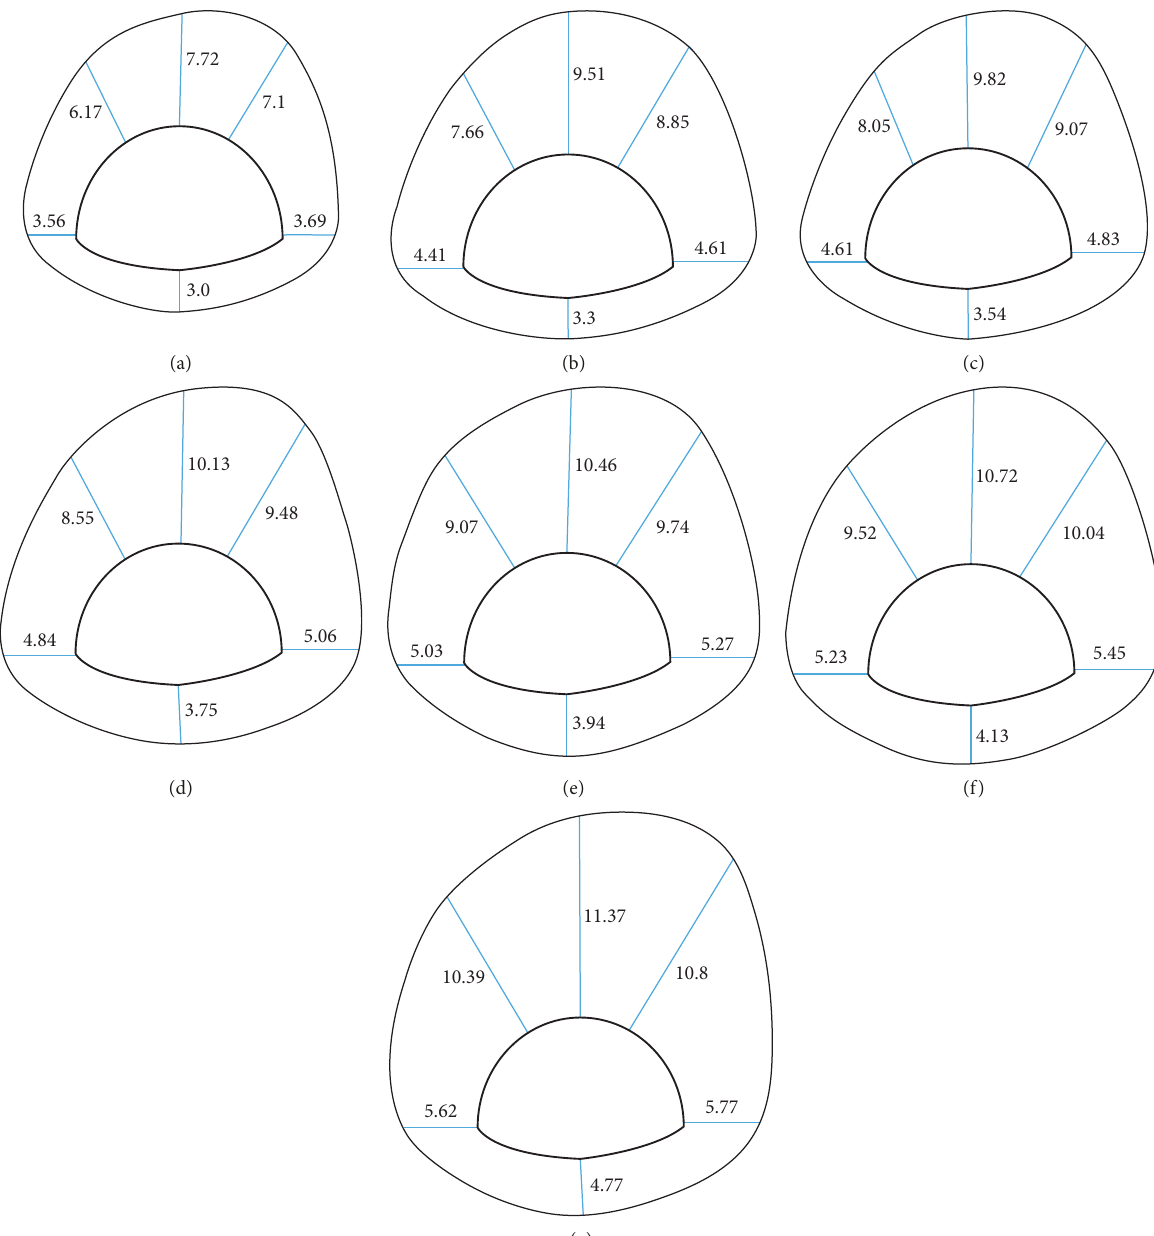
Figure 12: Displacement distribution under different slope coefficients when the rock layer dip is 30 ° . (a) Before. (b) ω � 3. (c) ω � 4. (d) ω � 5. (e) ω � 6. (f) ω � 7. (g) ω �